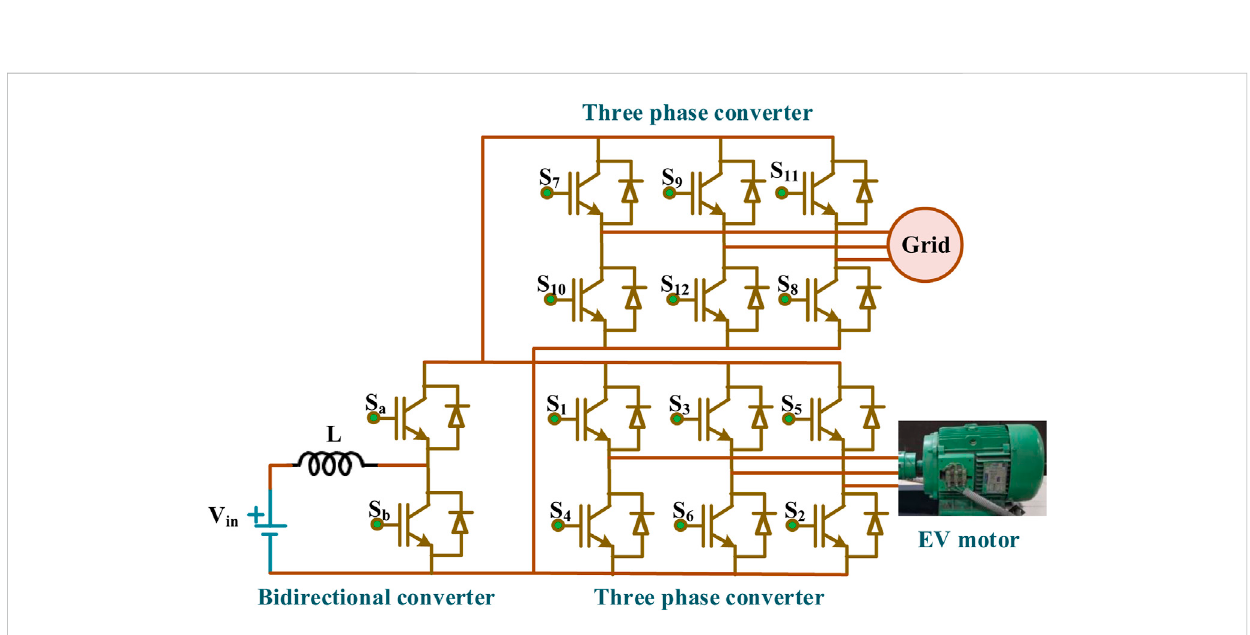
FIGURE 2 Overview of EV system with power electronic